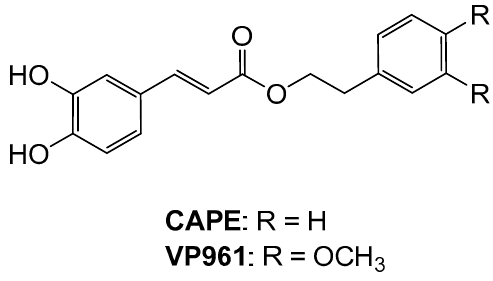
ff eic acid phenethyl ester (CAPE) and VP961-CAPE Figure 1. Chemical structure of caffeic acid phenethyl ester (CAPE) and VP961-CAPE derivative. Figure 1. Chemical structure of ca